Question: State the chart type depicted above.
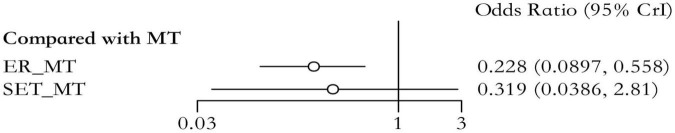
Answer: forest